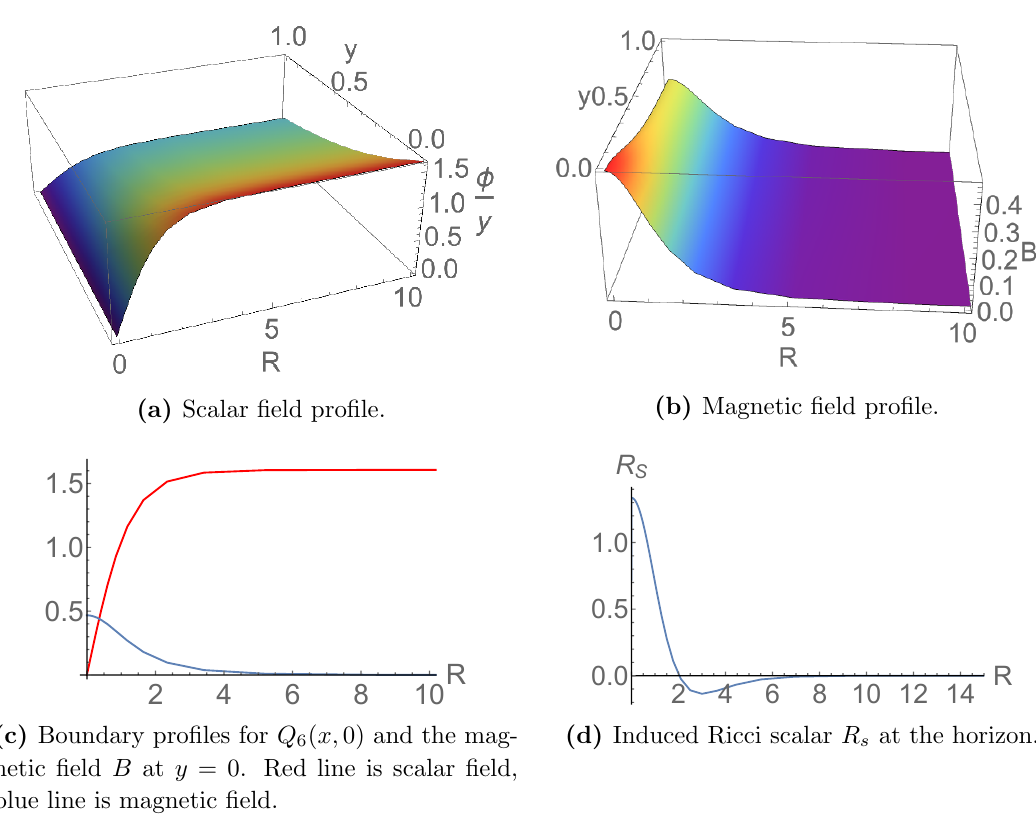
Figure 2. Solutions of the gravitating Abrikosov-like vortex at, q = L = n = 1, (cid:20) = (cid:0) 1, y + = 1 = 2, plotted as a function of the physical radial coordinate R